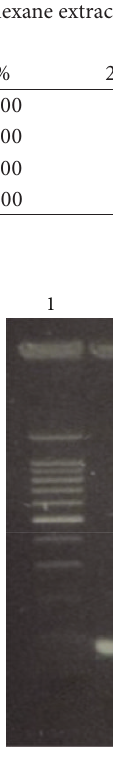
Figure 1: Culture on CRA: black colonies of slime-producing S. aureus .